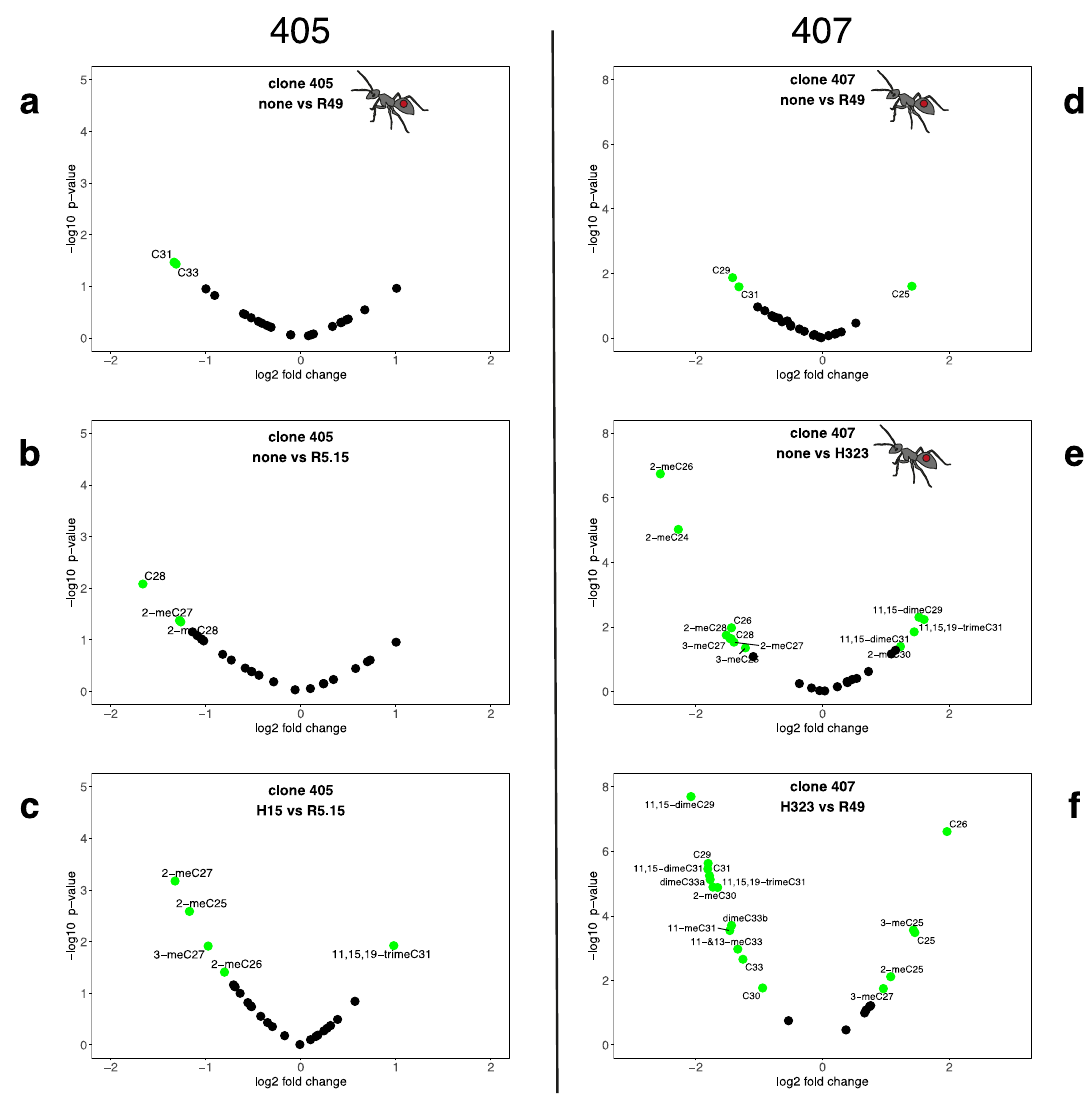
Figure 2. Volcano plots highlight the differences between uninfected and endosymbiont infected aphids ( a , b , d , e ) and between aphids with different endosymbiont infections ( c , f ). The left column shows comparisons within clone 405 and the right column within clone 407. Points highlighted in green represent compounds with P values < 0.05 and log-fold changes > 0.5. The combinations in plots ( a ),( d ) and ( e ) were used in the behavioural ant